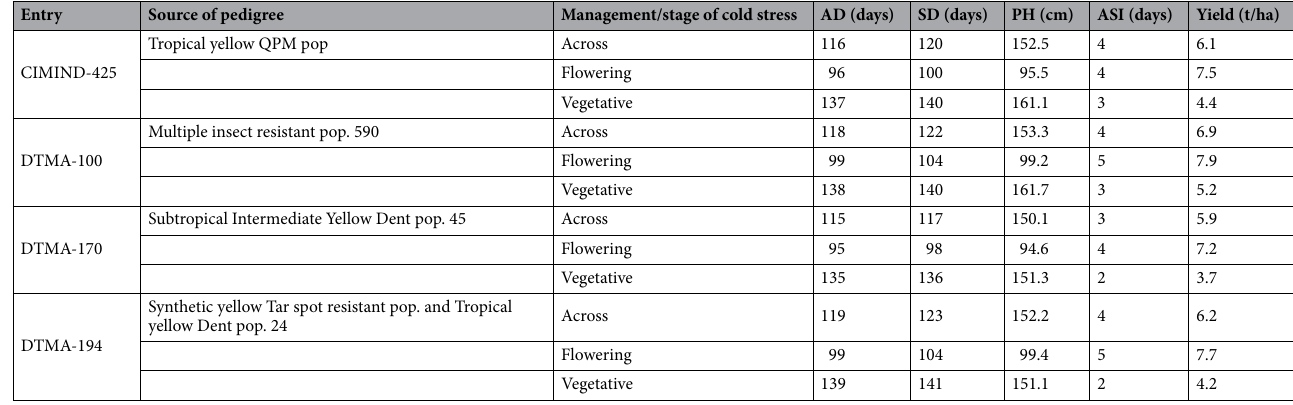
Table 3. Test cross performance of selected Asia adapted lines under cold stress across different crop growth stages. AD, SD and ASI represents Days to 50% anthesis, Days to 50% Silking and Anthesis-silking interval